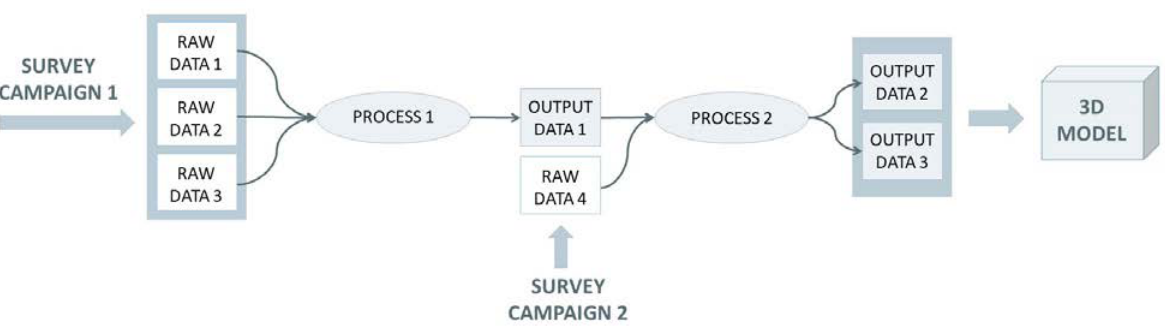
Figure 6_Schematic example of a survey